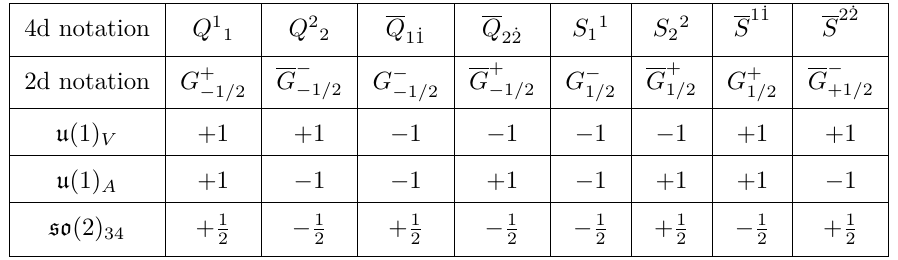
Table 1 . The supercharges preserved in the presence of a surface defect and their charges under u (1) V , u (1) A and so (2) 34 . The normalization of 2d operators in terms of the 4d notation contains factors of 1 (see equations (B.9), 2